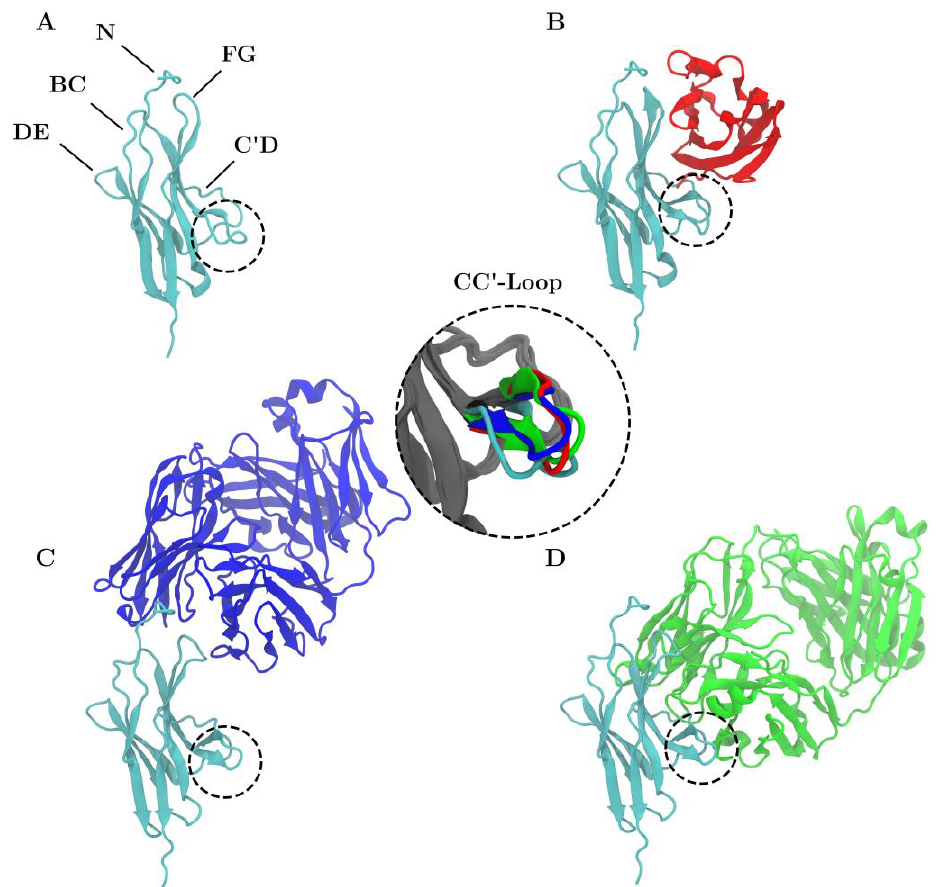
Figure 1. Structure of PD-1 (cyan) is shown unbound (  ) and in complex with PD-L1 ( B ), nivolumab ( C ) and pembrolizumab ( D ). The CC’-loop is highlighted with a dashed circle. The ( C ) and pembrolizumab ( D ). The CC (cid:48) -loop is highlighted with a dashed circle. The color of the color of the CC’-loop in the inset denotes the system of origin. The CC’-loop of PD-1 Apo is in the CC (cid:48) -loop in the inset denotes the system of origin. The CC (cid:48) -loop of PD-1 Apo is in the open con- open configuration whereas the CC’-loop of PD-1 PD-L1 (red), PD-1 Niv (blue), and PD-1 Pem (green) are figuration whereas the CC (cid:48) -loop of PD-1 PD-L1 (red), PD-1 Niv (blue), and PD-1 Pem (green) are in in the ‘closed’ configuration. the ‘closed’